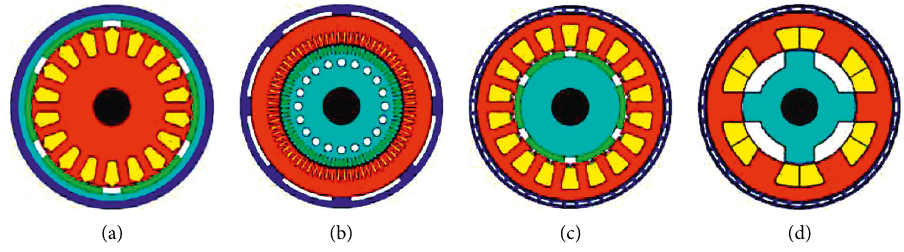
Figure 7: Cross section of traction motors. (a) DC motor. (b) IM. (c) SPM. (d) SRM.